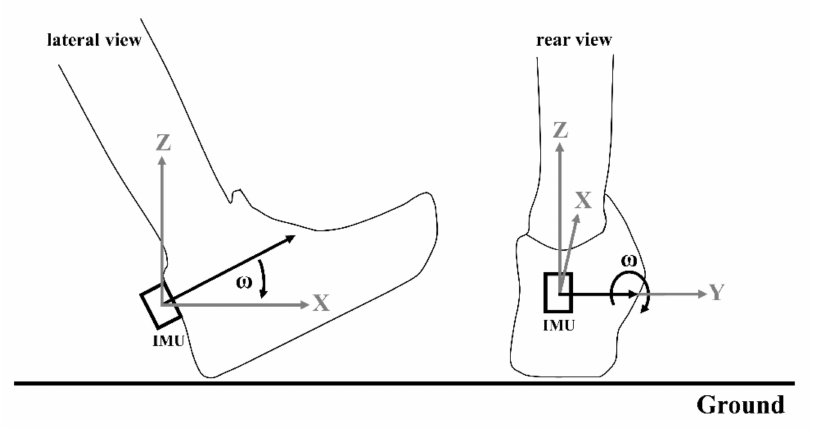
Figure 1. Sensor setup to measure the peak angular velocity in the sagittal